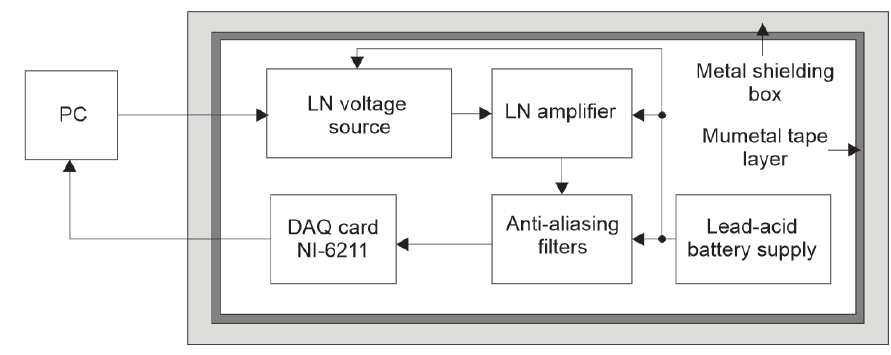
Figure 2. Block diagram of the measurement set-up.